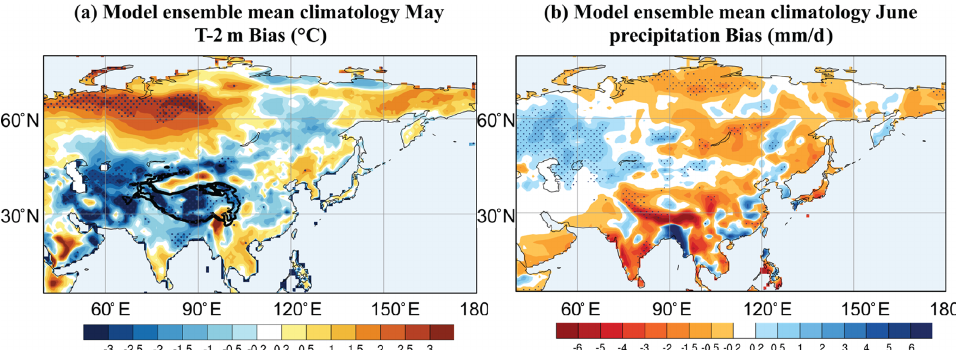
Figure 7. Thirteen LS4P-I ESM ensemble mean climatology